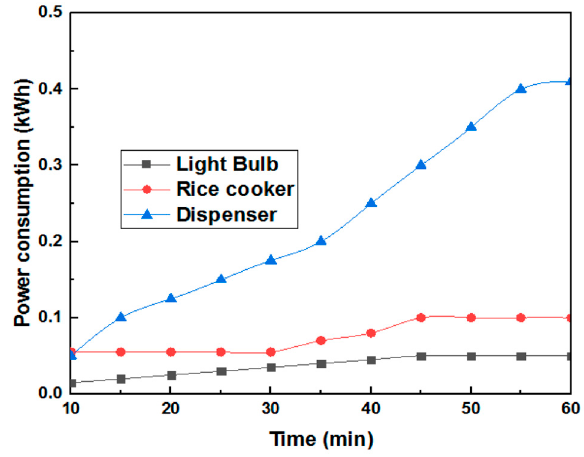
Figure 15. Power consumption